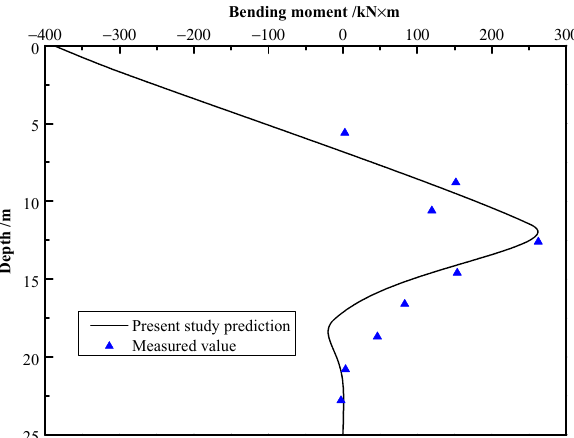
Figure 8. Comparison of present study prediction and measured